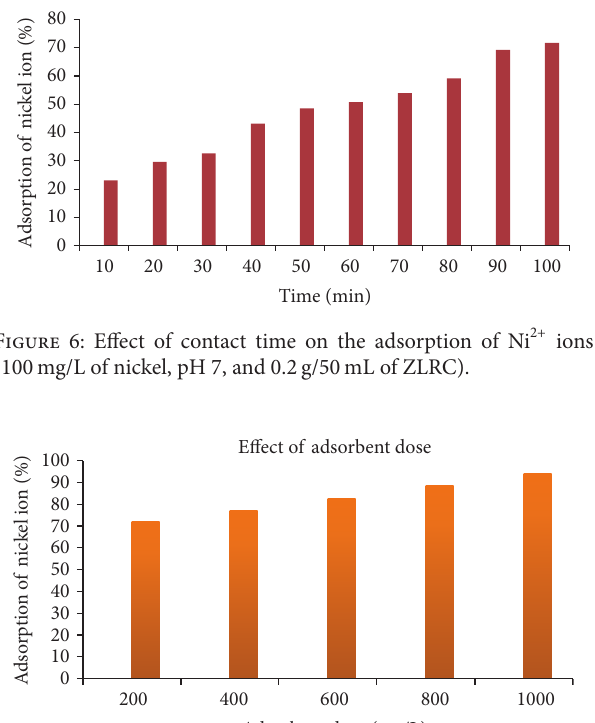
Adsorbent dose (mg/L) F 7: Effect of adsorbent dose on the removal of Ni concentration 100mg/L, contact time 2h, solution pH ZLRC (Ni 2+